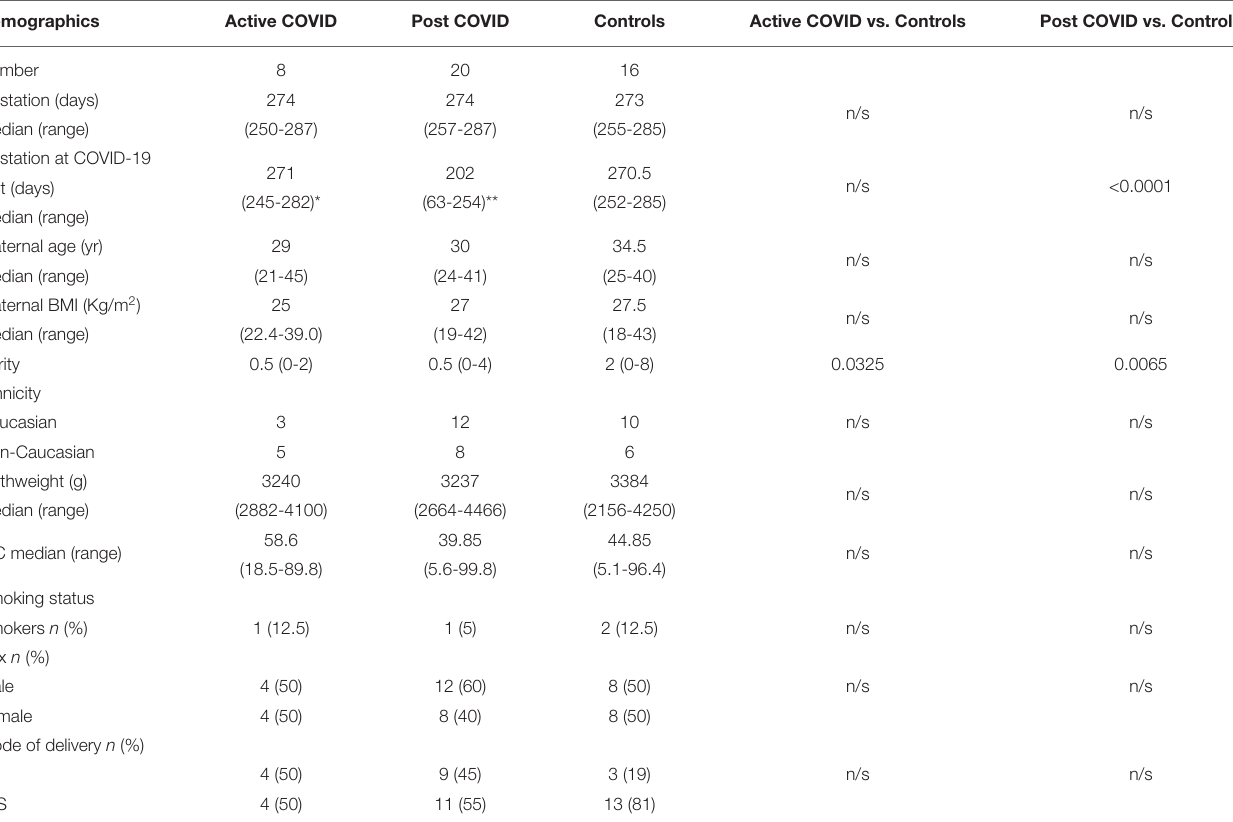
TABLE 1 | Participant demographics for Active COVID, Post COVID, and control